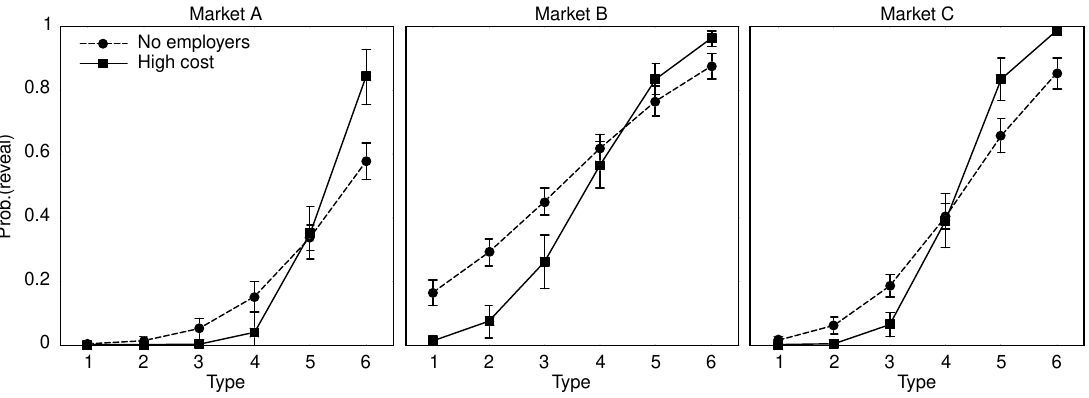
Figure 3. Probabilities of revelation and standard errors implied by the probit regressions in Table